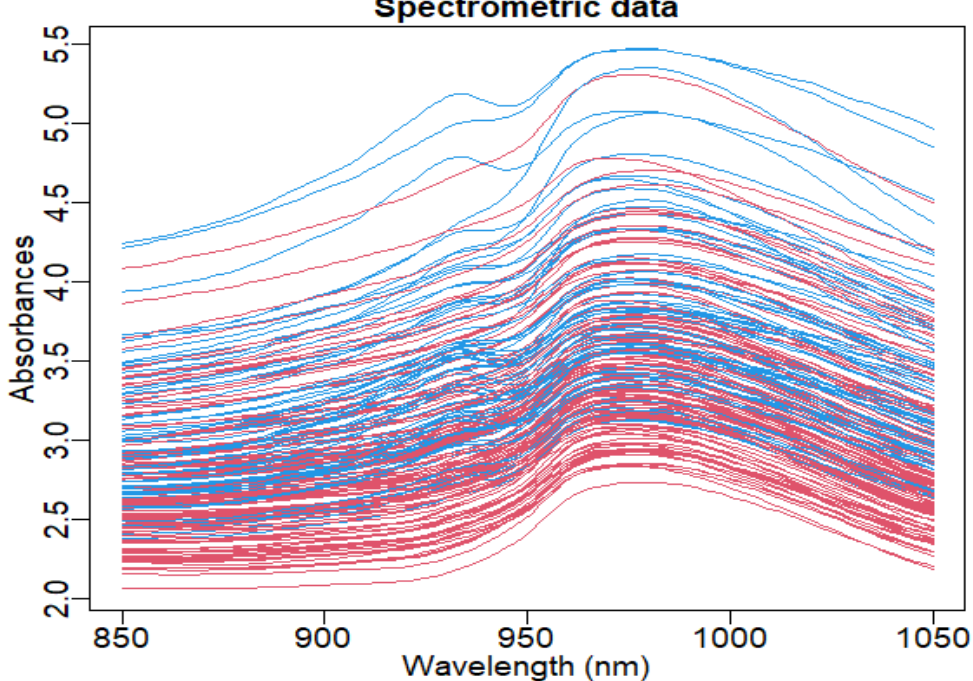
Figure 5. Sample of 100 absorbance curves Z